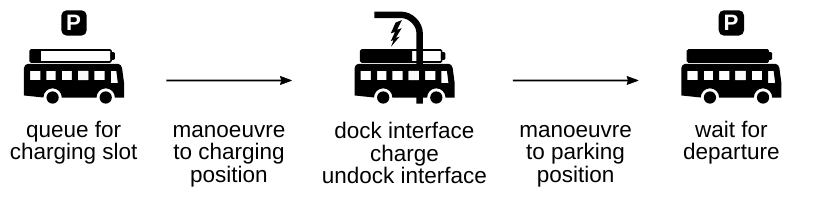
Figure 6. Actions controlled by charging